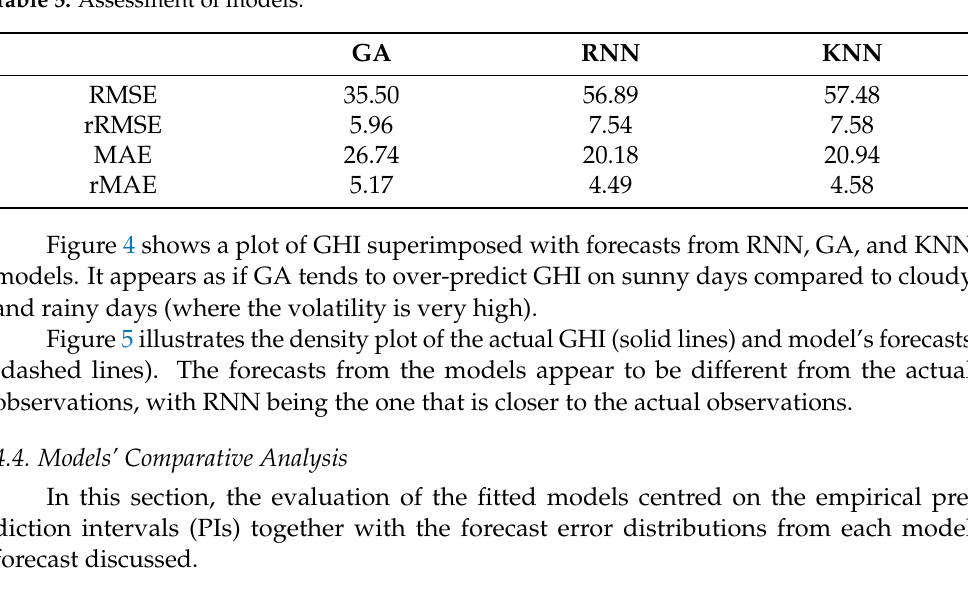
Table 5. Assessment of